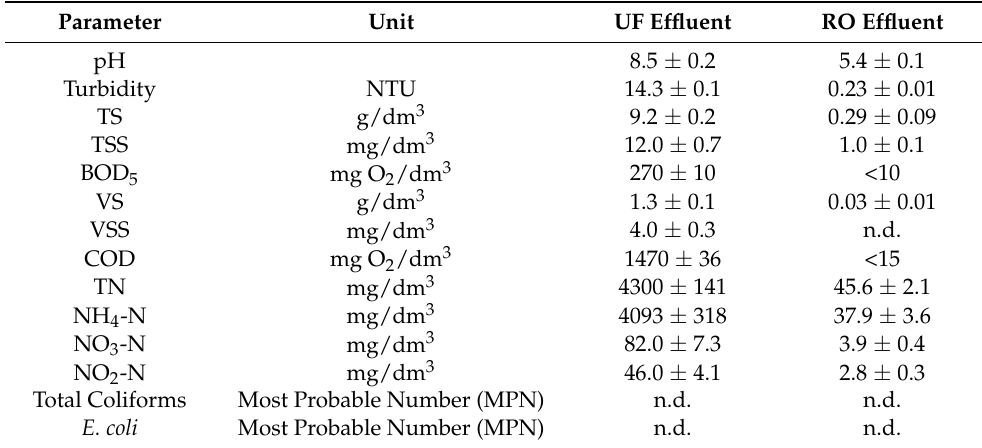
Table 6. Characteristics of effluent of the Ultrafitration and RO process.